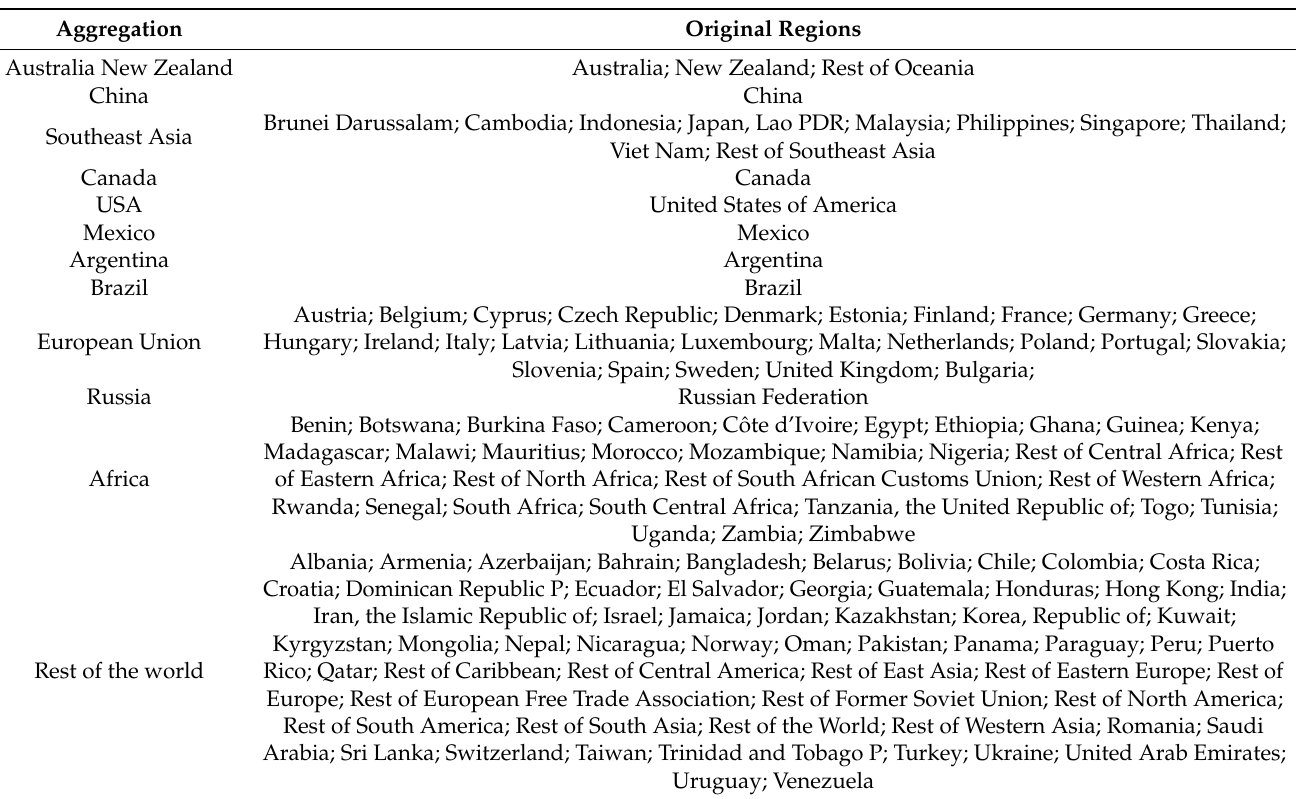
Table A2. Regional Aggregation of GTAP